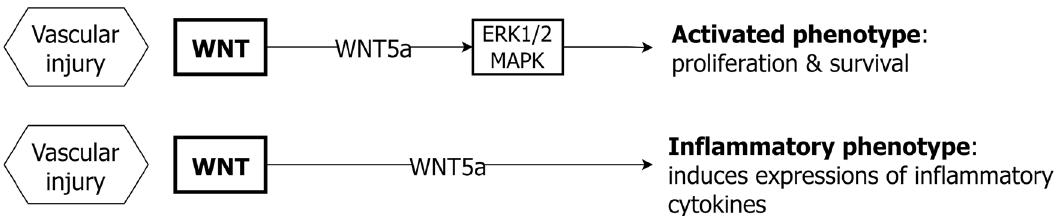
Figure 4. Summary of the mechanisms of WNT signaling pathways in EC. Under vascular injury, WNT5a and ERK1/2/MAPK dependent signaling leads to an activated phenotype and can promote an inflammatory phenotype.